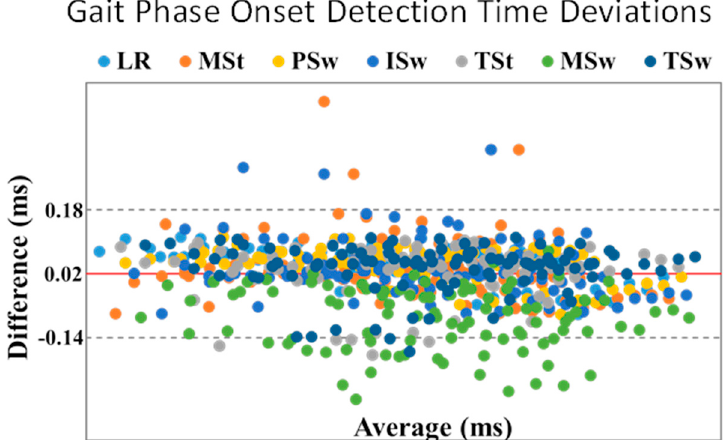
Figure 6. Bland–Altman plot for phase onset detection between CP gait phase detection (GPD) and motion capture (MoCap). Limits of agreement (gray dashed line) are the averaged difference (red line) ± 2 SD. Each color represents a gait phase, i.e., loading response (LR), mid-stance (MSt), terminal stance (TSt), pre-swing (PSw), initial swing (ISw), mid-swing (MSw) and terminal swing (TSw). A total of 700 data points were used from both CP GPD and MoCap.